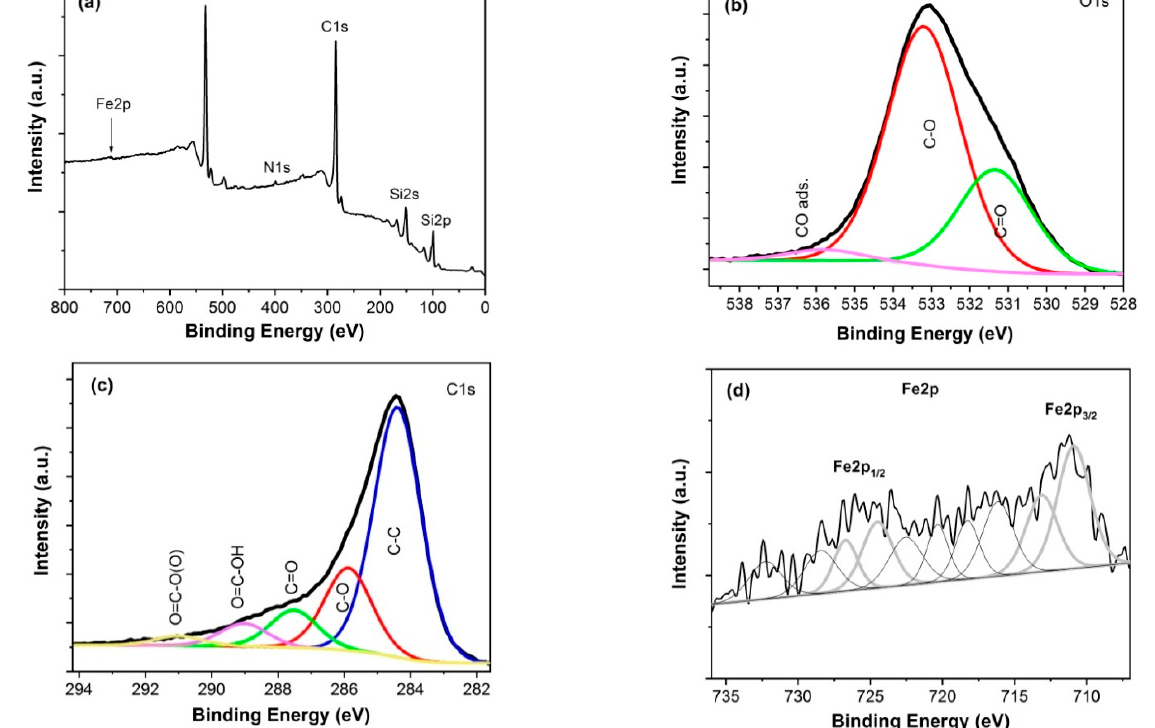
Figure 5. XPS spectra for rGO/Fe 2 O 3 multilayer: ( a ) wide scan, ( b ) HR O1s, ( c ) HR C1s, ( d ) HR Fe2p.